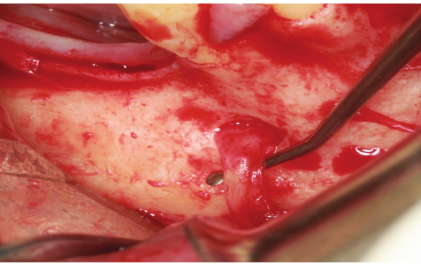
Figure 24: Mental isolated nerve.